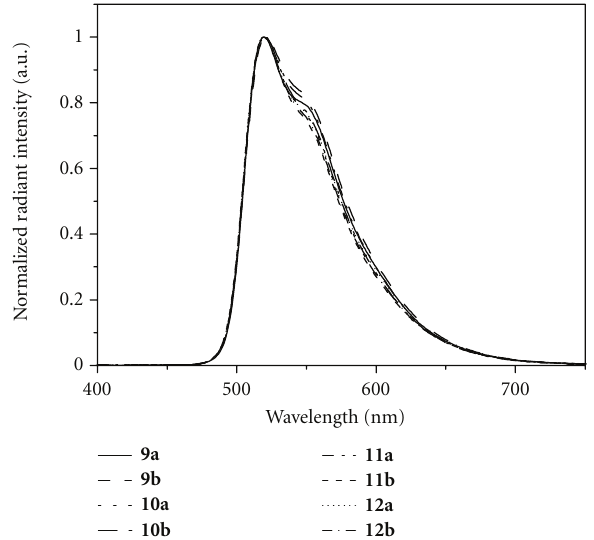
Figure 16: Electroluminescence spectra of OLEDs using di ff erent electron-transporting polymers ( 9a/b – 12a/b ) in the emitting